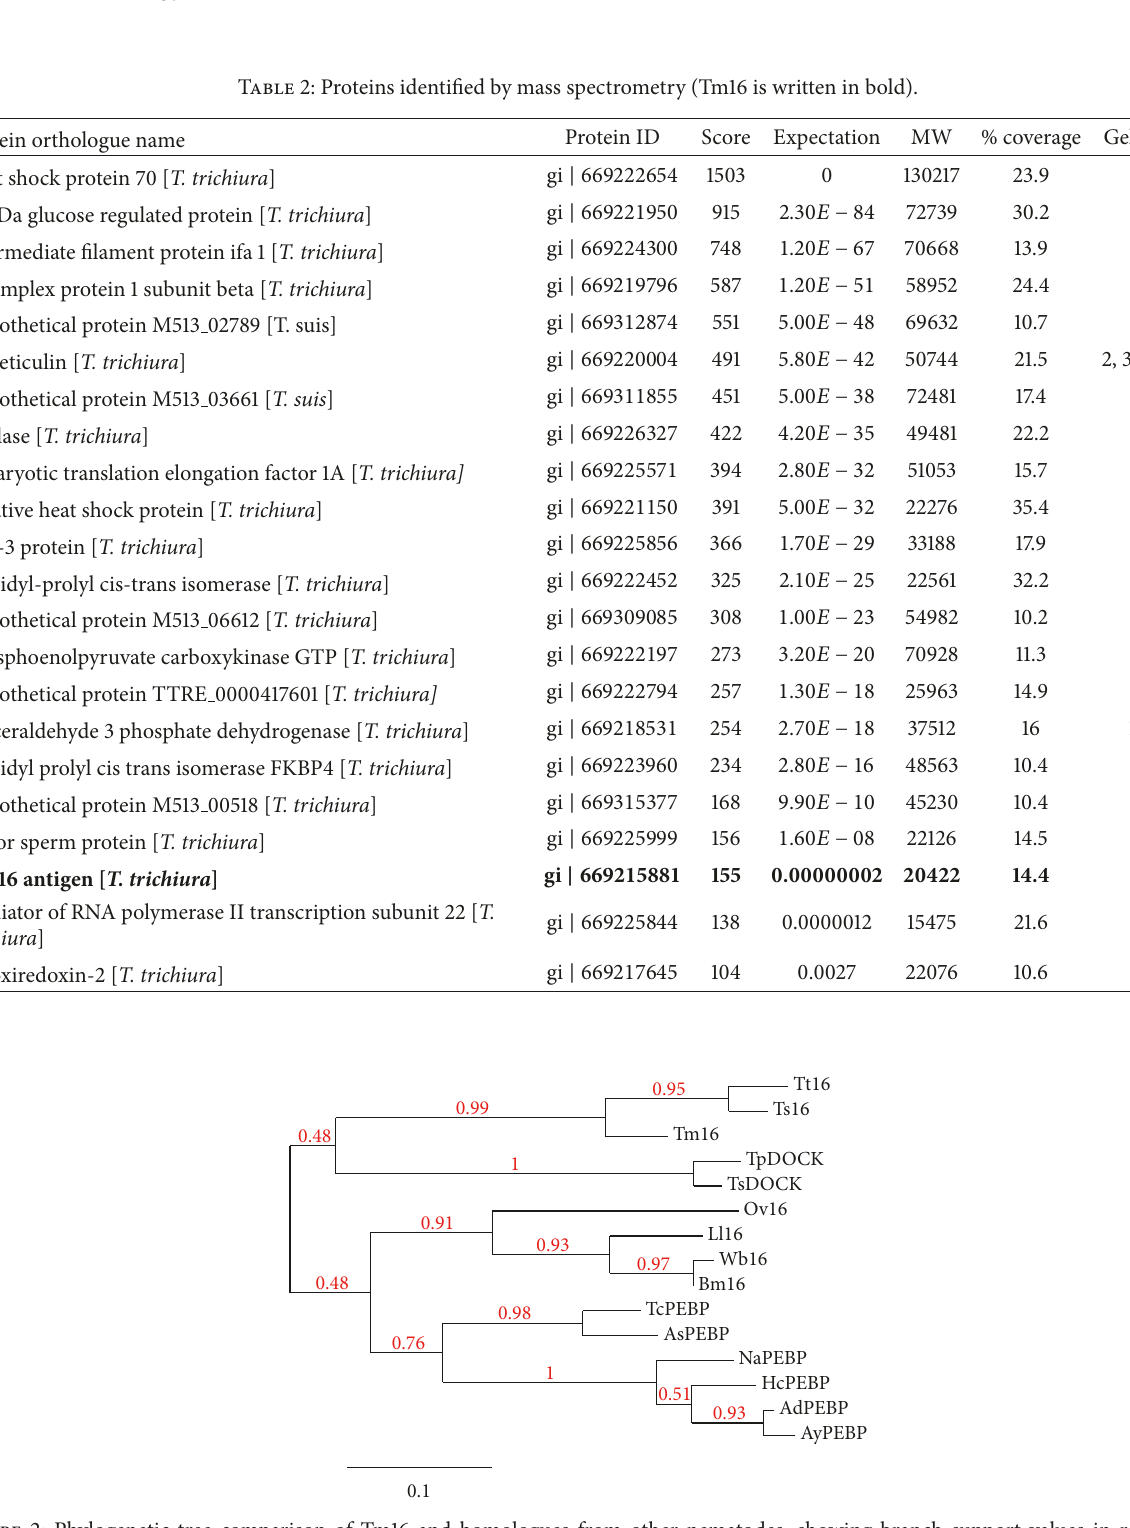
Figure 2: Phylogenetic tree comparison of Tm16 and homologues from other nematodes, showing branch support values in red. Tt16 ( Trichuris trichiura , GenBank: CDW60800.1); Ts16 ( T. suis : KHJ42858.1); TpDOCK ( Trichinella pseudospiralis : KRX98670); Ll16 ( Loa loa : EJD73732.1); AdPEBP ( Ancylostoma duodenale : KIH55180.1); TcPEBP ( Toxocara canis : KHN87196.1); TsDOCK ( Trichinella spiralis : KRY40094.1); HcPEBP ( Haemonchus contortus : CDJ94417.1); AsPEBP ( Ascaris suum : ERG86178.1); AyPEBP ( Ancylostoma ceylanicum